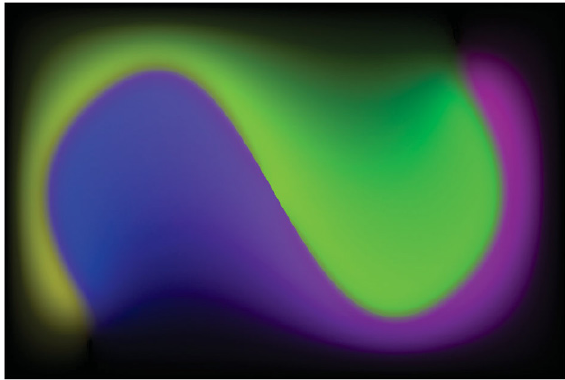
Fig. 6 Generate a blurring effect by setting appropriate strength coefficients for pixels on the separating